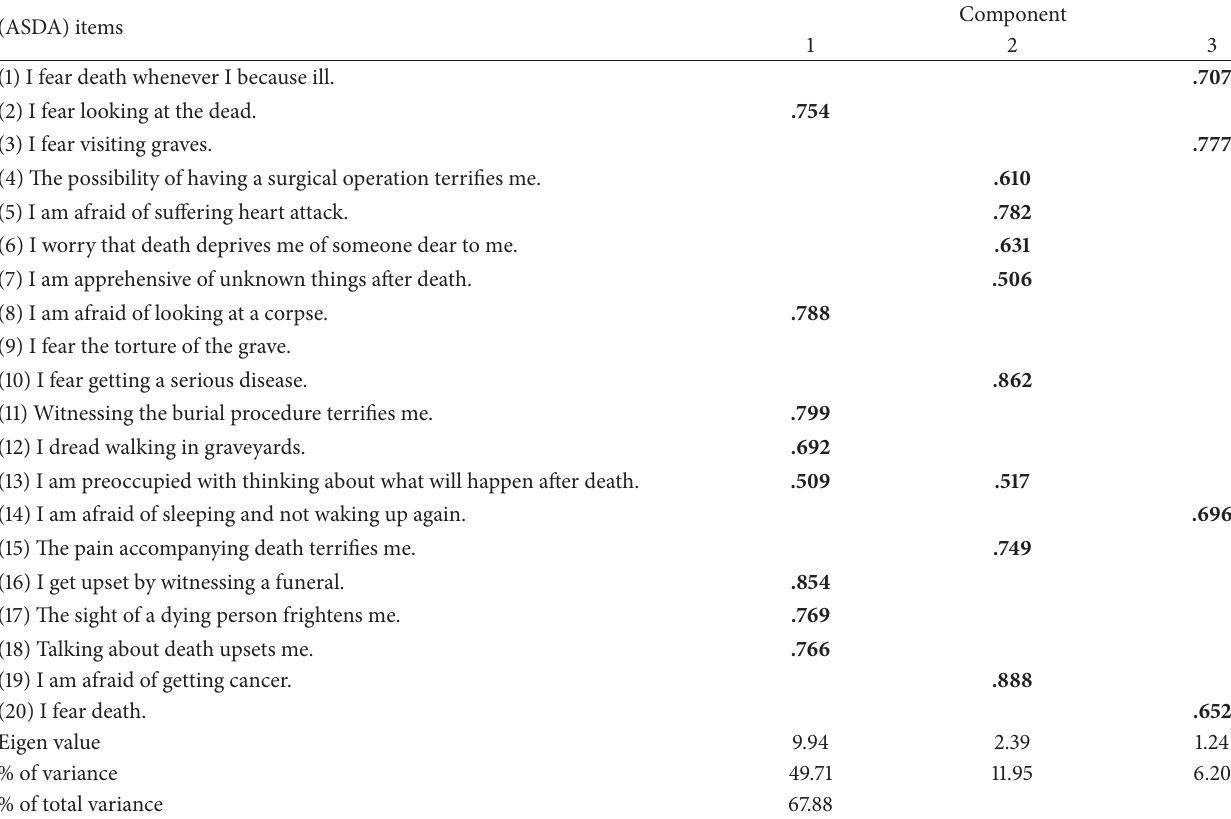
Table 3: Factor loadings of the Farsi version of the Arabic Scale of Death Anxiety (ASDA) in Iranian elders ( 𝑁 = 146 ). (ASDA)